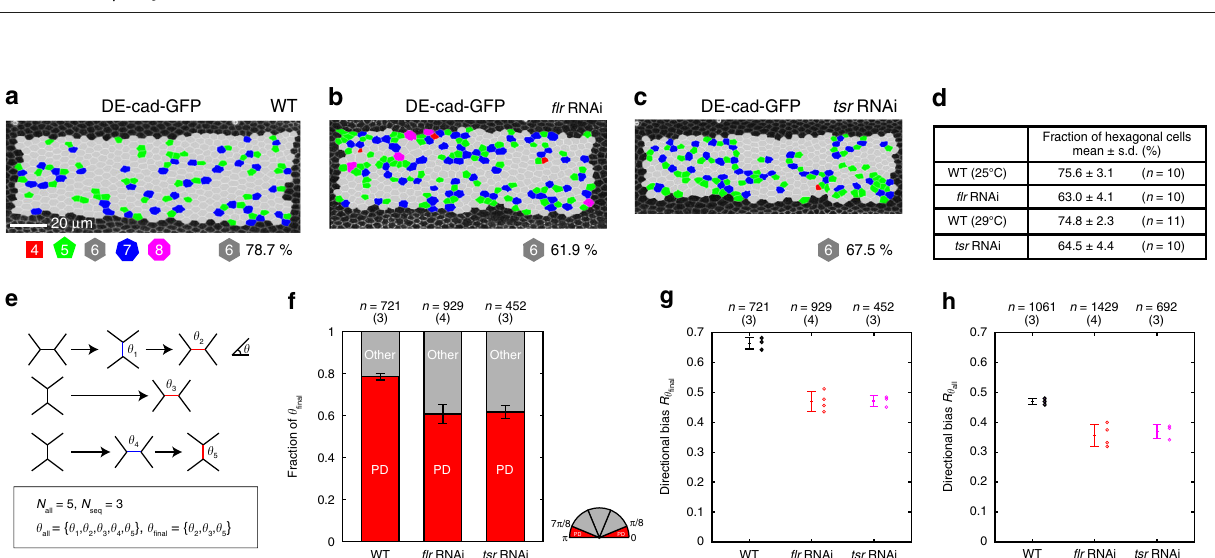
Fig. 1 AIP1 localizes to remodeling AP junctions in the Drosophila pupal wing. a AIP1-GFP (left) and an AJ marker, D α -cat-TagRFP (right) in the WT wing at 24 h APF. Blue arrowheads indicate AP junctions. b Directional bias of AIP1-GFP signal intensity (left) and D α -cat-TagRFP signal intensity (right) along the junctions. Each junction is divided into twelve bins according to its angle relative to the PD axis, and the average signal intensity in each bin is plotted. Blue arrows indicate the length R s and orientation Θ of an angular mean vector (Methods and Supplementary Figure 1e) 7 . c , d Top-view ( c ) and side-view ( d ) of cells expressing AIP1-GFP (left) and D α -cat-TagRFP (right) at 24 h APF. The vertical section along the dashed arrow in panel c is shown in d . Alphabets indicate corresponding coordinates in different views. e , g Selected snapshots from movies of AIP1-GFP (gray in top panels, green in bottom panels) and D α -cat-TagRFP (red in bottom panels). Blue arrowheads indicate remodeling ( e ) and stable ( g ) junctions. f , h Plot of AIP1-GFP signal intensity (green, left y -axis) and length (blue, right y -axis) of AP junctions undergoing cell rearrangement ( f ) or not ( h ). In f , t = 0 indicates the time point when the junction was reconnected. Data shown in h indicate that bleaching was negligible. i Snapshots of utrABD-GFP before and after photobleaching (square indicates ROI). t = 0 indicates the time point when photobleaching was conducted. j, k utrABD-GFP in ROIs examined before and after photobleaching along the AP ( j ) and PD ( k ) junctions. Color maps are shown in the upper right. l The stable fraction of utrABD-GFP. Welch ’ s t -test: AP vs. PD, P < 0.01. The number of junctions examined is indicated ( b , f , h , l ). Data are presented as the mean ± s.e.m. ( b ) and as the mean ± s.d. ( f , h , l ). Scale bars: 5 µ m ( a , e , g ), 2 µ m ( c , d , i ), and 0.5 µ m ( j )